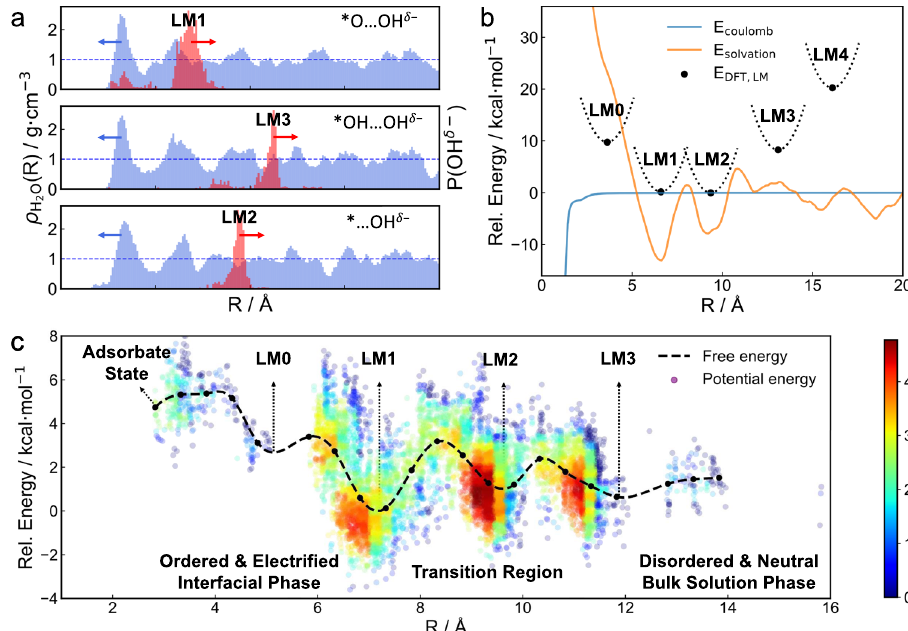
and the probability density P(OH δ − ) of pseudo- Fig. 4 Analysis of the origin of the pseudo-adsorption state. a The water density distribution ρ H 2 O adsorbed OH δ − in systems of *O … OH δ − , *OH … OH δ − , and * … OH δ − , from equilibrated AIMD trajectories. b Thermodynamic insight into the pseudo- adsorption state. c Approximated free energy pro fi le of the pseudo-adsorbed hydroxide based on AIMD trajectories, obtained by integrating out the degrees of freedom other than R. The AIMD data points are colored by frequency of occurrence (in logarithm scale) according to the color bar on the right. The “ LM ” denotes the local minima by performing geometry optimization on selected con fi guration with the pseudo-adsorbed hydroxide at different